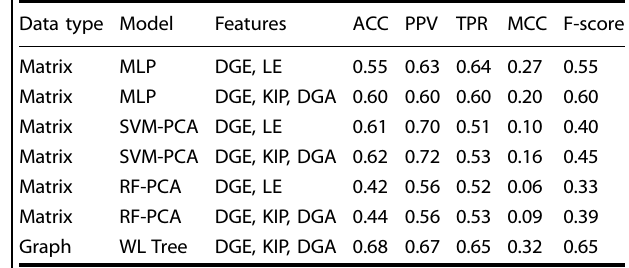
Table 2. Performance of algorithms to predict the response of cancer cell lines to